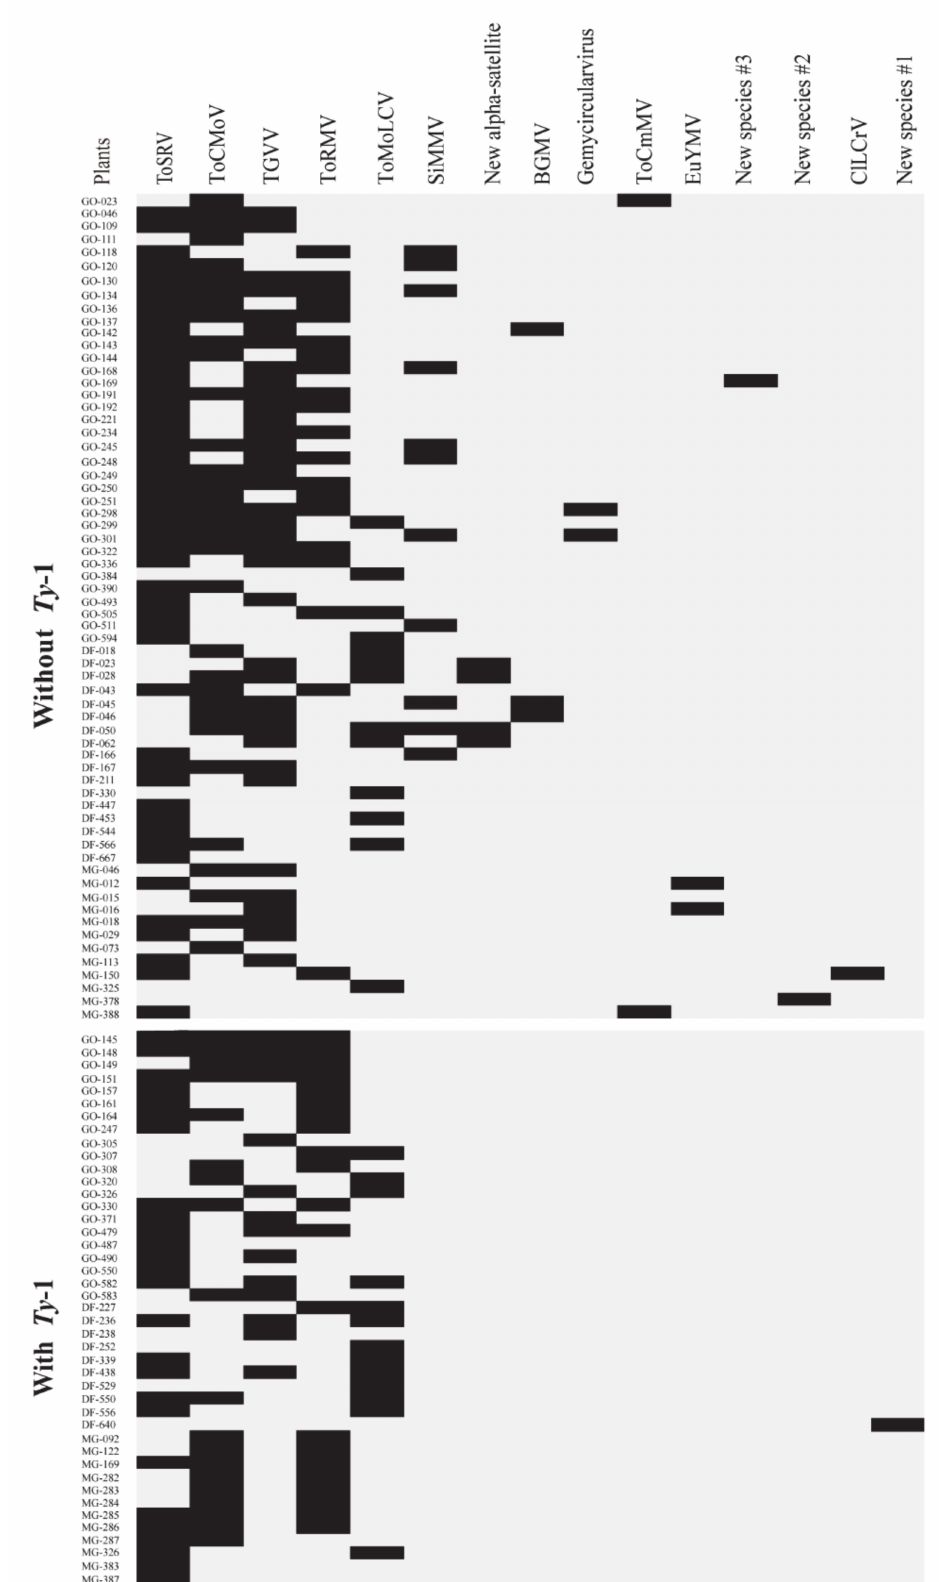
Figure 1. Frequency and relative predominance of Begomovirus species and single-stranded DNA viruses detected with Illumina Hiseq sequencing of tomato samples with ( n = 43) and without ( n = 64) the Ty -1 gene. Results were validated by PCR assays with virus-specific primers and by Sanger